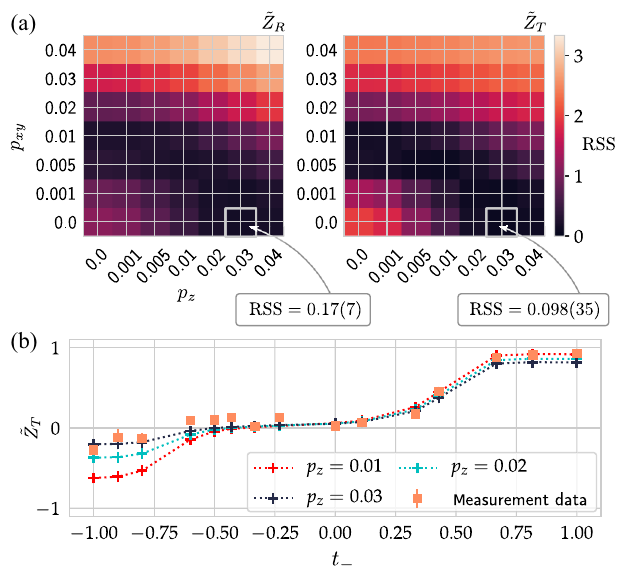
FIG. 13. Goodness-of-fit estimation via residual sum of squares for the weighted Pauli error model. We compare the model with ˜ Z ˜ Z X and Y FIG. 14. (a) Residual sum of squares of the weighted Pauli error the data for R and T individually in (a). As we expect model for the MBTIs errors to occur with the same probability, we assume p p p p 0 and p initial state with mean phonon number ¯ n ¼ 0 . 05 for different x ¼ y ¼ xy . The best fit is achieved for xy ¼ z ¼ 0 . 098 ð 35 Þ in ˜ Z 0 . 03 with RSS ¼ 0 . 17 ð 7 Þ in ˜ Z probabilities p xy;z . We obtain a RSS ¼ 0 . 15 ð 7 Þ in R and RSS ¼ T 0 . 081 ð 32 Þ [average RSS ¼ 0 . 12 ð 5 Þ ] shown in (b) for ˜ Z shown in (b), respectively.